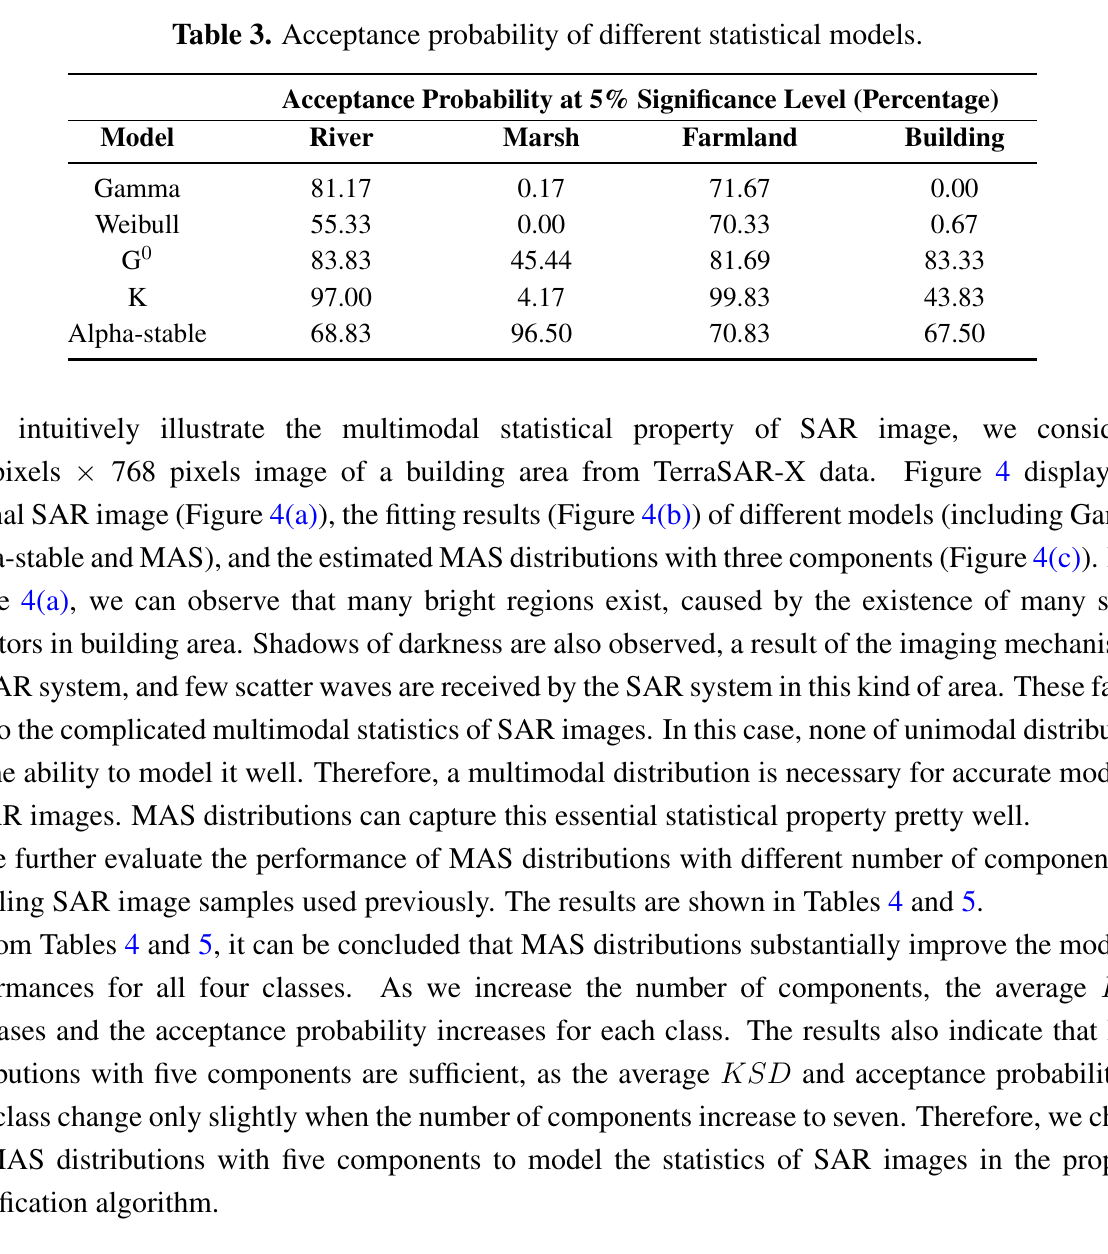
Table 3. Acceptance probability of different statistical